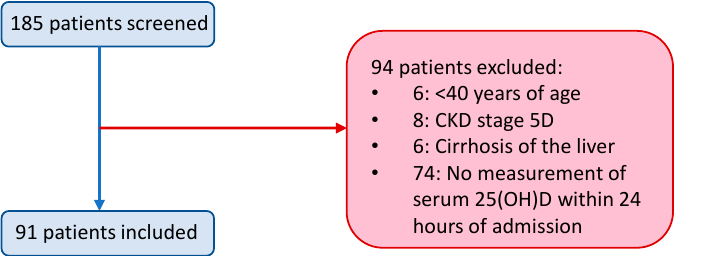
Figure 1. Patients initially screened, those excluded and included in the study. CKD = chronic kidney disease.